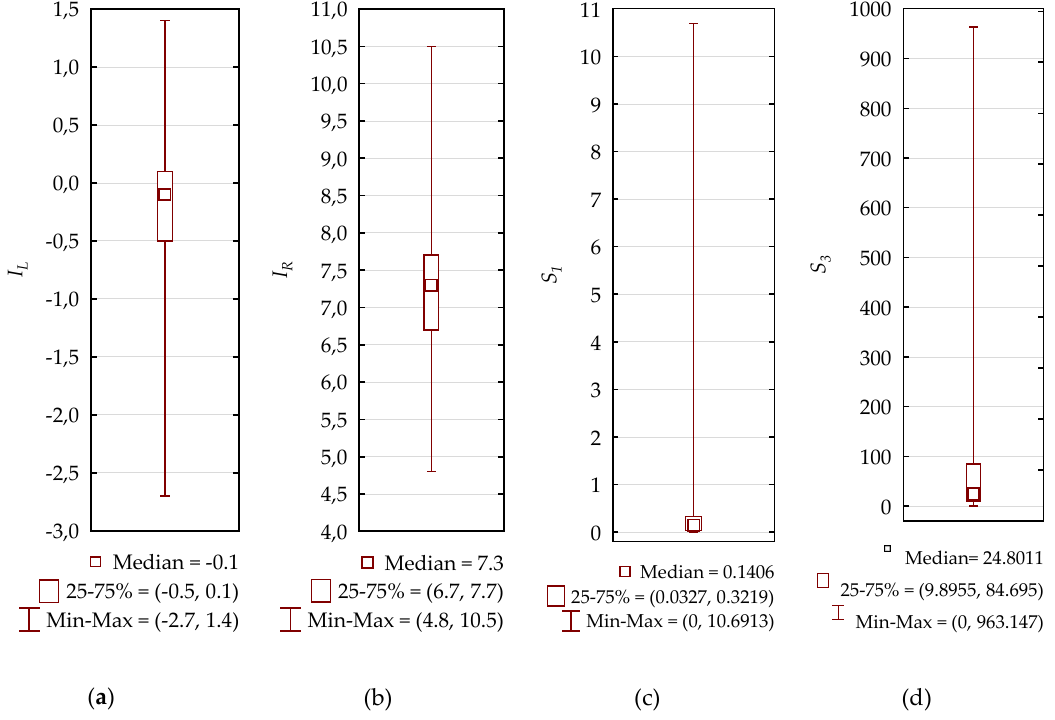
Figure 2. Indices for the corrosiveness of bottled mineral waters. Box plots for ( a ) the Langelier index— I L , ( b ) the Ryznar index — I R , ( c ) S 1 , and ( d ) S 3 . index— I L , ( b ) the Ryznar index— I R , ( c ) S 1 , and ( d ) S 3